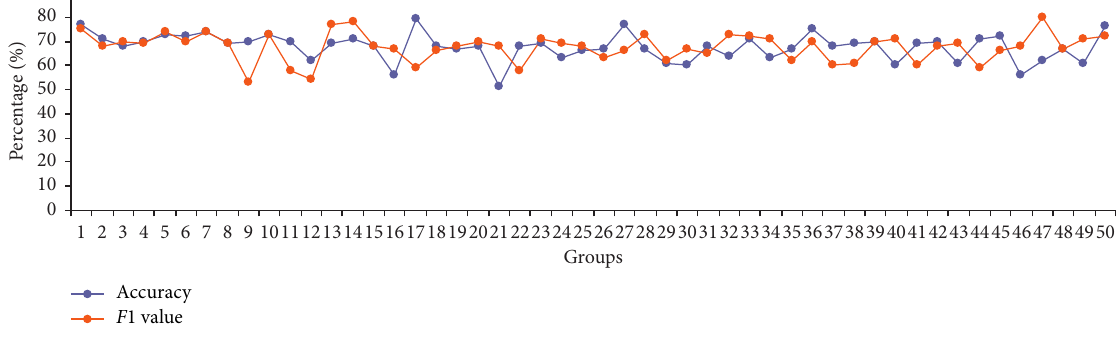
Figure 13: Line chart of accuracy and F 1 value.